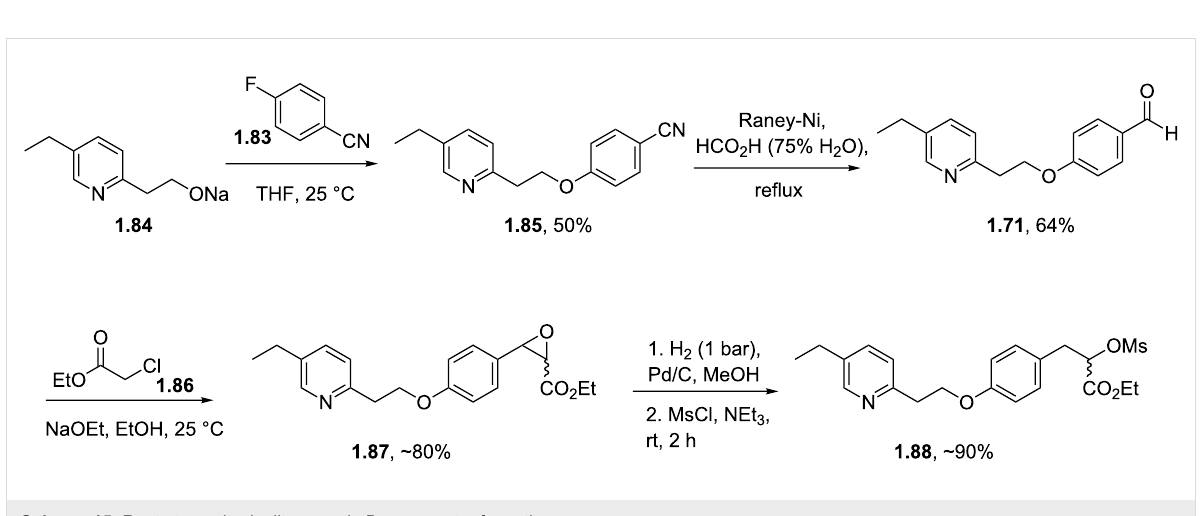
Scheme 15: Route towards pioglitazone via Darzens ester